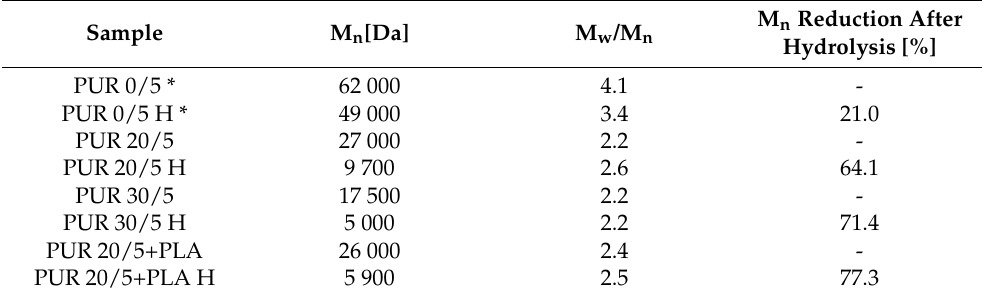
Table 3. Molecular weight of PUR 0/5, PUR 20/5, PUR 30/5 and PUR 20/5+PLA samples before and after 36 weeks of degradation in buffer